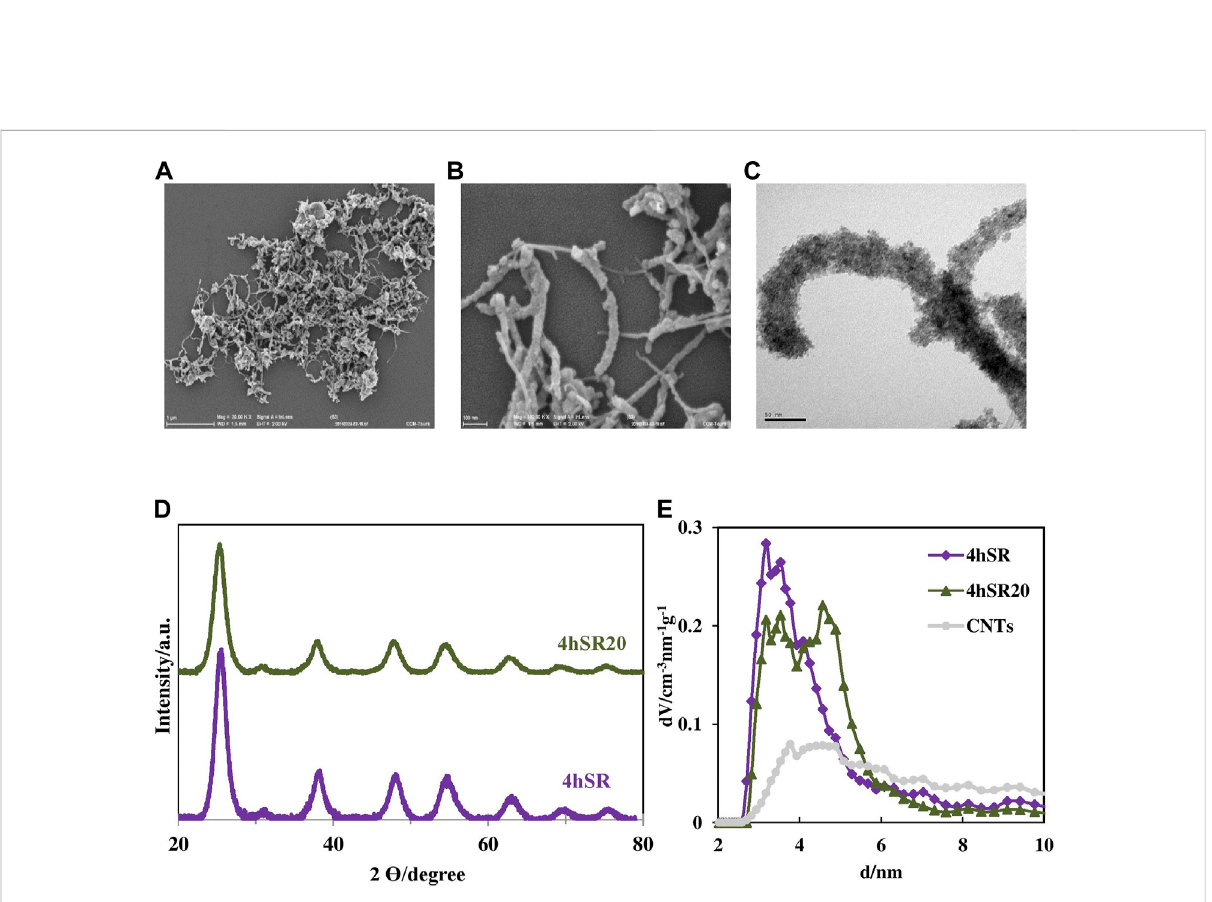
FIGURE 10 (A) SEM image, (B) HR SEM image and (C) TEM image of the 4hsR20 TiO 2 /CNT composite. Physicochemical characterization of 4hSR TiO 2 and its composite with 20 wt% CNTs (4hSR20): (D) XRD patterns and (E) DFT pore size